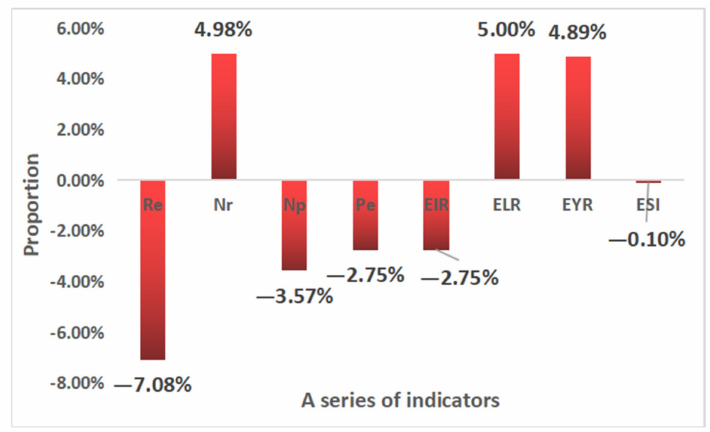
Figure 14. The variation range of key indicators based on a 5%